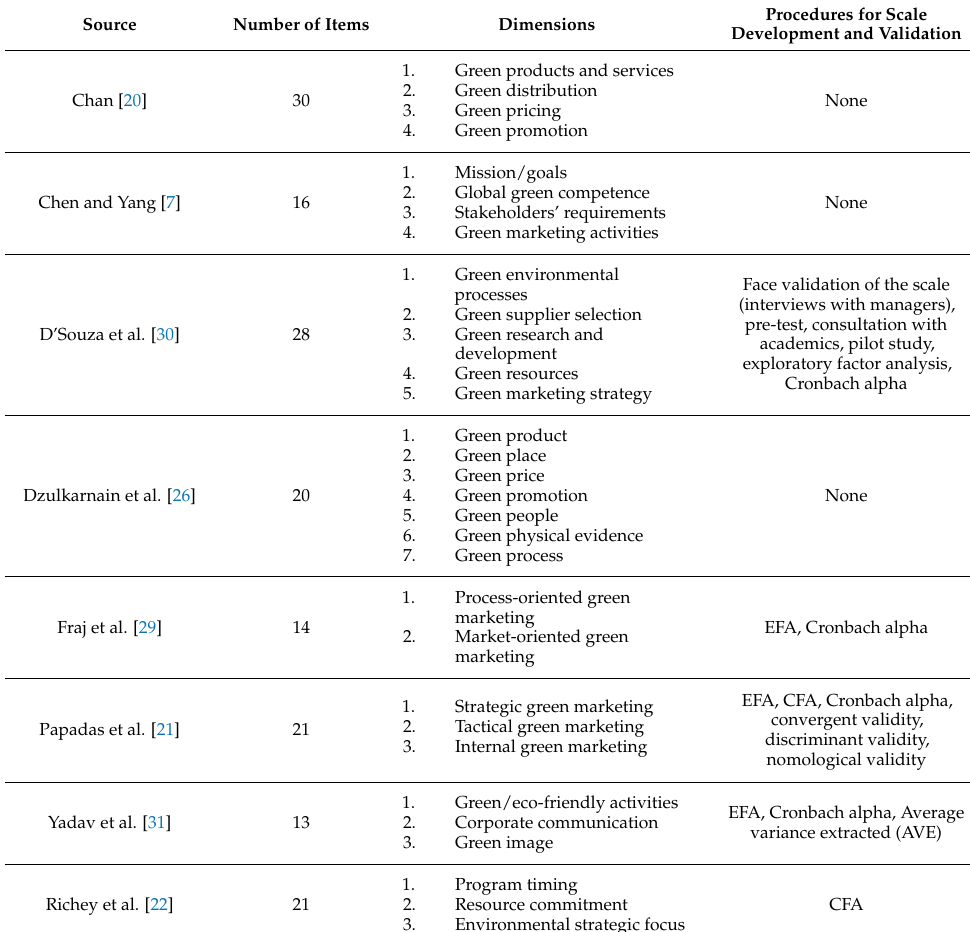
Table 1. Description of instruments for the measurement of green